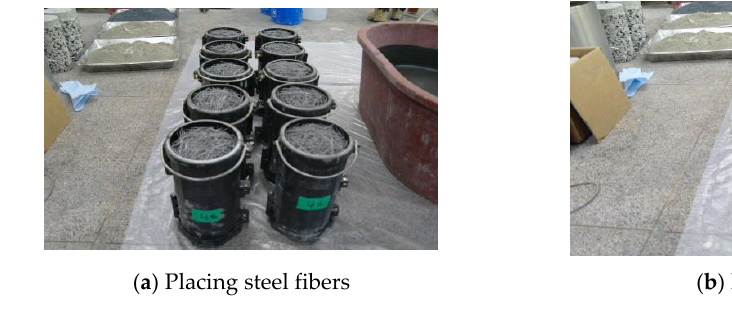
Figure 2. Fabrication of specimens.